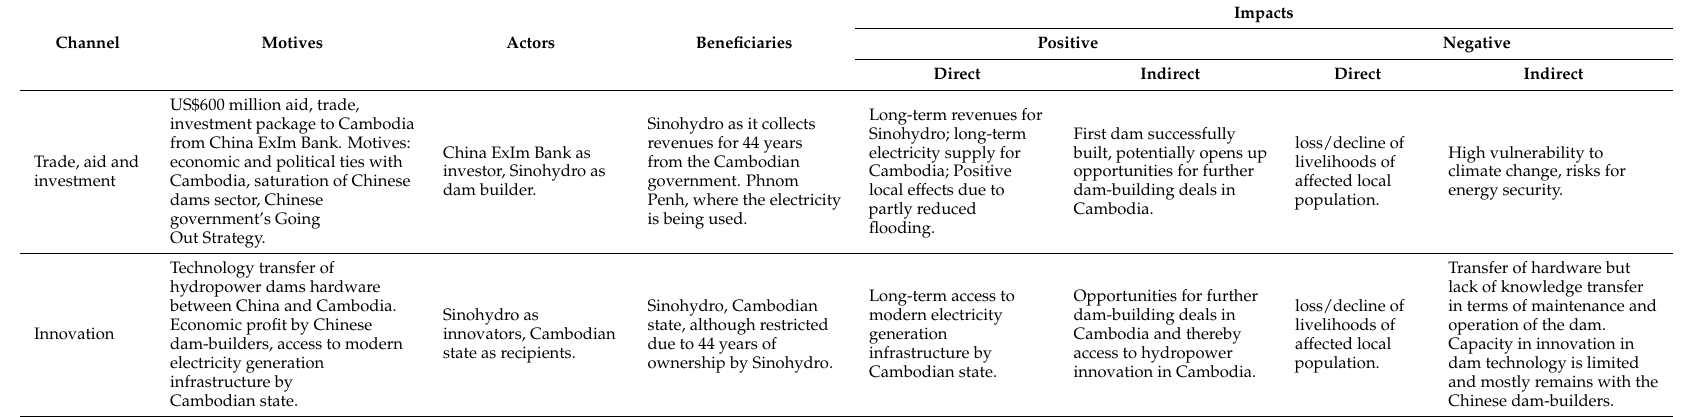
Table 7. Channels of interaction between Chinese actors and Cambodian actors, according to an amended version of the Asian Drivers framework, see Urban et al., 2011